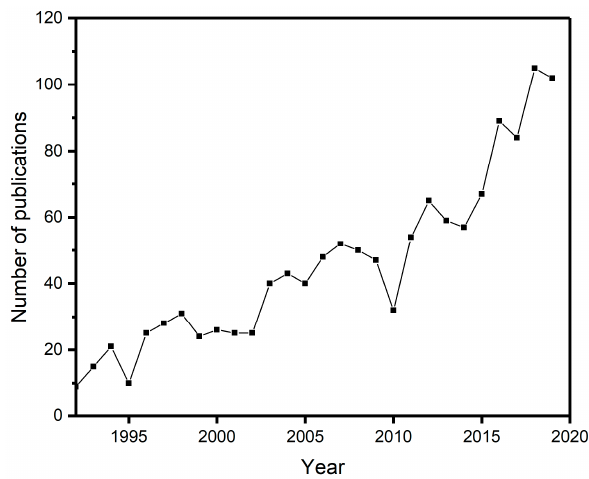
Figure 1. Annual publications on heat pulse method for soil physical measurements based on data from Science Citation Index Expanded (SCI-EXPANDED) database of the Web of Science Core Collection (WoSCC).